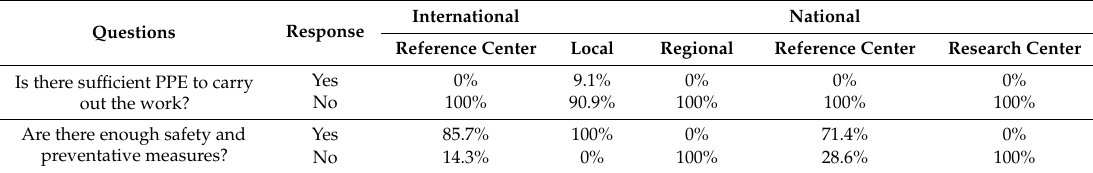
Table 3. Frequency of responses of the workers.